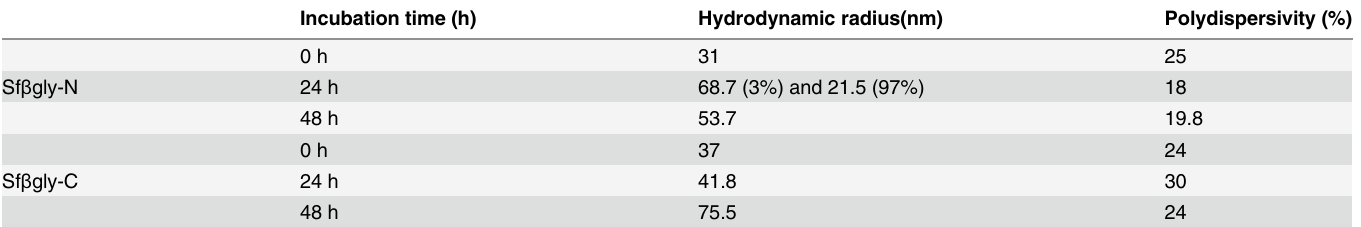
Fig 4. Acrylamide quenching of Sf β gly-N and Sf β gly-C fluorescence. Purified samples of Sf β gly-N (A) and Sf β gly-C (B) were used for the determination of fluorescence spectra (excitation, 295 nm; emission, 305 to 450 nm) at different concentrations of acrylamide ([Q], 0 to 0.47 M). The maximum emission was determined at the same wavelength in the absence (F 0 ) and presence (F) of acrylamide. Spectra were determined after incubation for 0 ( ■ ) and 48 h ( □ ) in 50 mM citrate-sodium phosphate buffer, pH 6.0. doi:10.1371/journal.pone.0139673.g004 Table 2. Characterization of Sf β gly-N and Sf β gly-Cby dynamic light